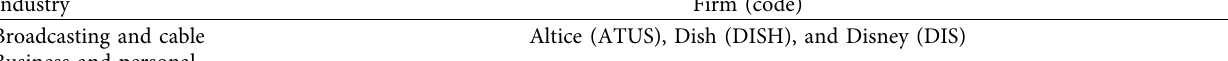
Table 1: Classification of the digital firm